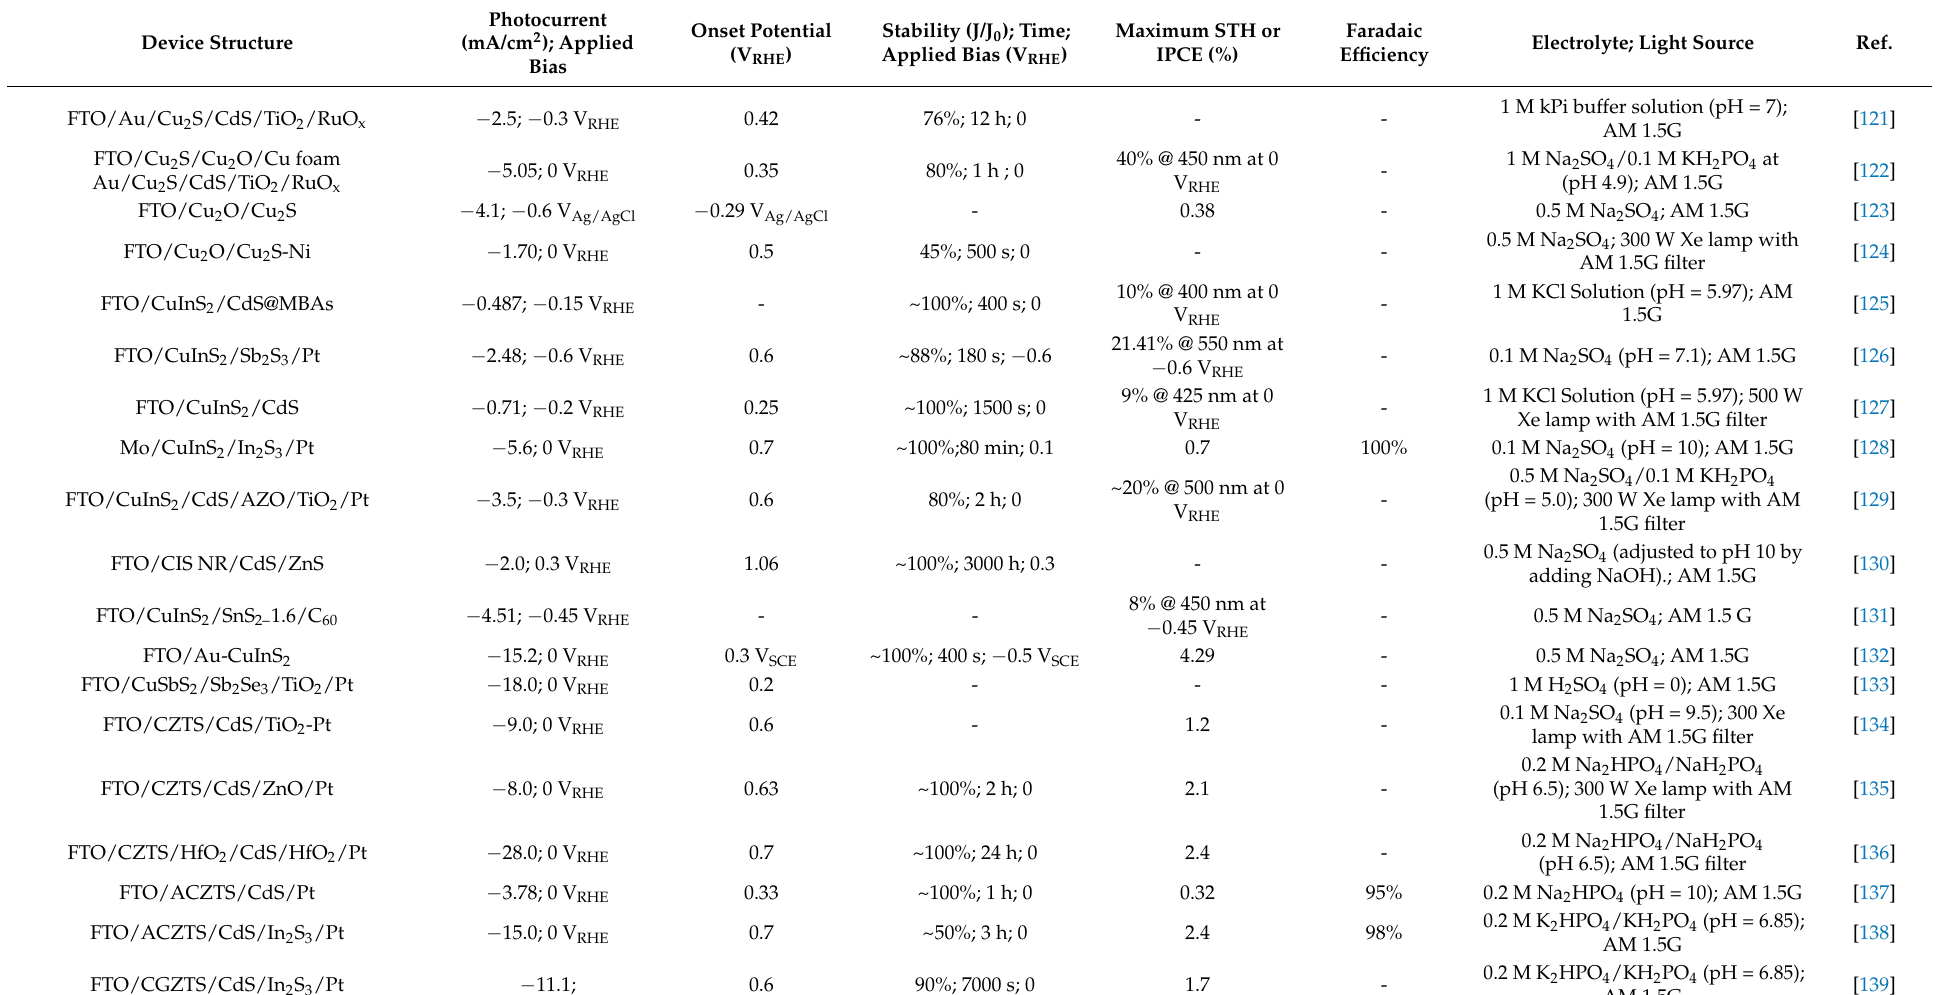
Table 2. Photoelectrochemical performances of the Cu-based metal sulfide photocathodes. Device